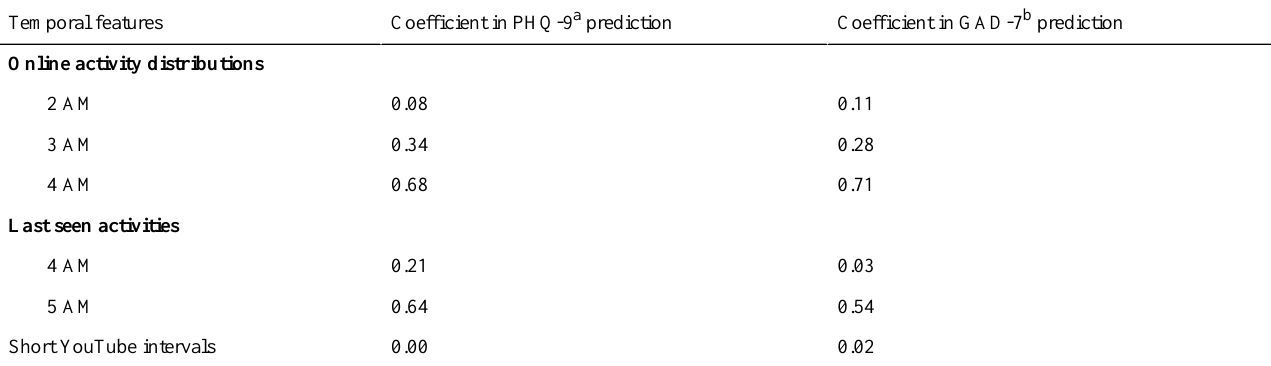
Table 6. The coefficients of 6 temporal features in lasso regression.